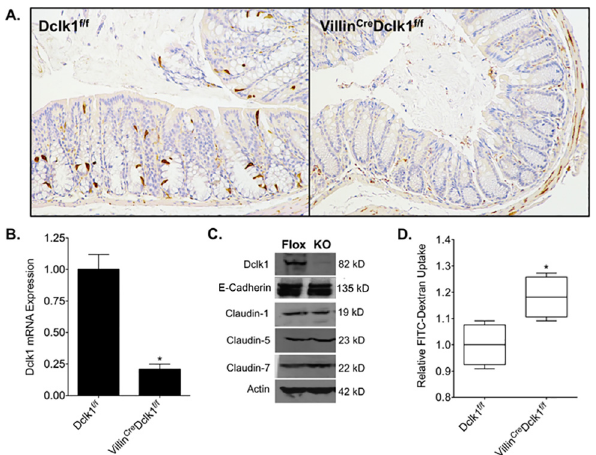
Fig 1. Characterization of intestinal epithelial deletion of Dclk1 under normal conditions. A. There is no detectable Dclk1 in the colonic epithelia of Villin Cre ;Dclk1 f/f mice. Colonic tissues stained with anti-Dclk1 antibody (Brown) under normal conditions (200x magnification). B . Dclk1 mRNA levels were dramatically decreased in the Villin Cre ;Dclk1 f/f mice; C . The expression levels of Dclk1 and TJPs in Dclk1 f/f and Villin Cre ; Dclk1 f/f mice; D . Intestinal mucosal integrity was impaired in the Villin Cre ;Dclk1 f/f mice. FITC-Dextran level in the serum of each mouse was determined 4 h after gavage (n = 3 for each group, * p <